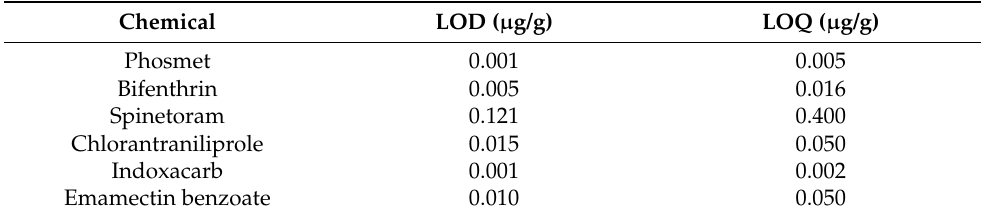
Table 2. LOD and LOQ values for each treatment